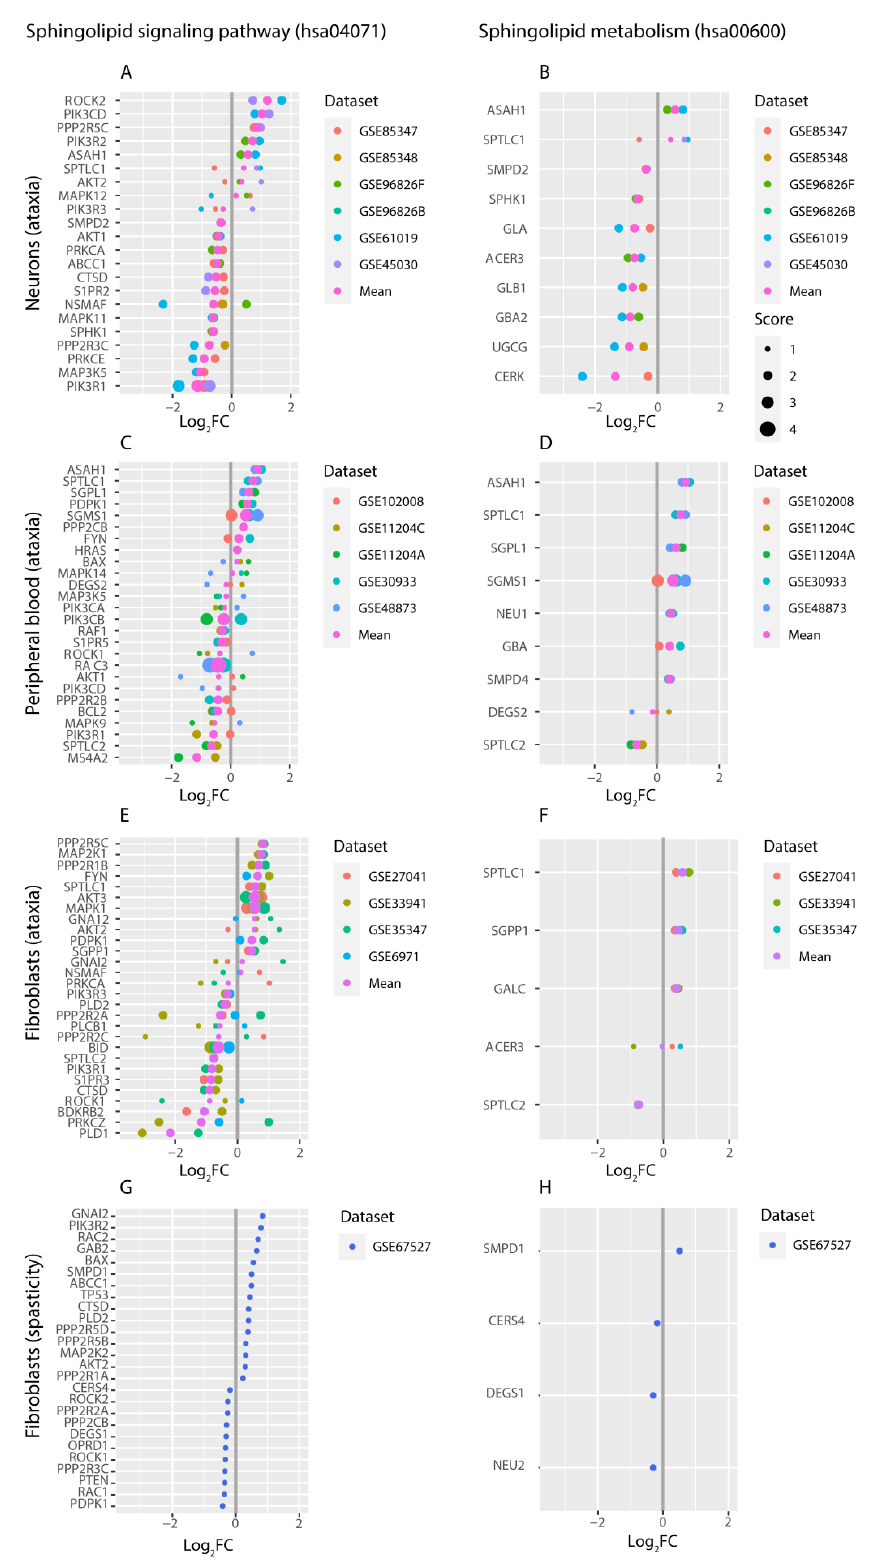
Figure 2. PathExNet analysis was used to generate lists of the di ff erentially expressed genes of each dataset that participate in the KEGG hsa04071 Sphingolipid signaling pathway and KEGG hsa00600 Sphingolipid metabolism. The genes that participate in KEGG hsa04071 with consistent di ff erential expression are presented for the ataxia datasets of ( A ) neurons, ( C ) peripheral blood, ( E )